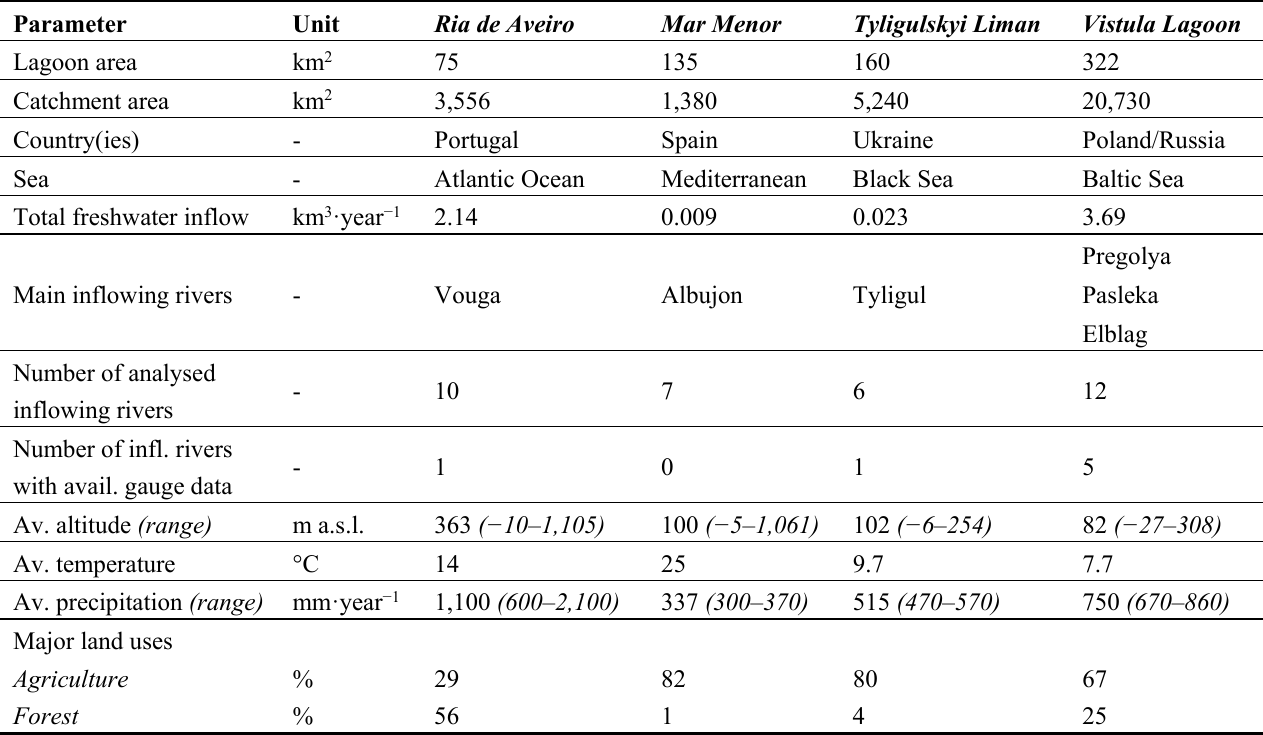
Table 1. Characteristics of the four case study areas investigated in the